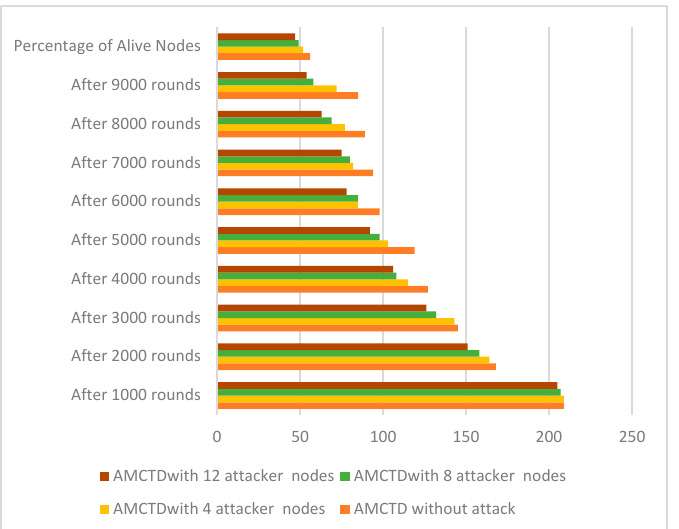
Figure 5. No. of Alive/Functional Nodes of AMCTD without Attack, AMCTD with 4, 8 and 12 At- tacker nodes. Attacker